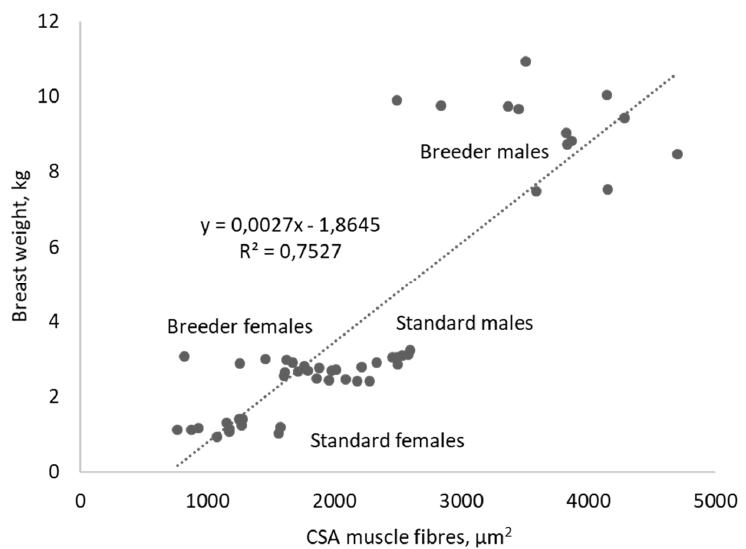
Figure 2. Relation between CSA of muscle fibers and breast weight from males and females of breeder and standard turkeys ( n = 13).